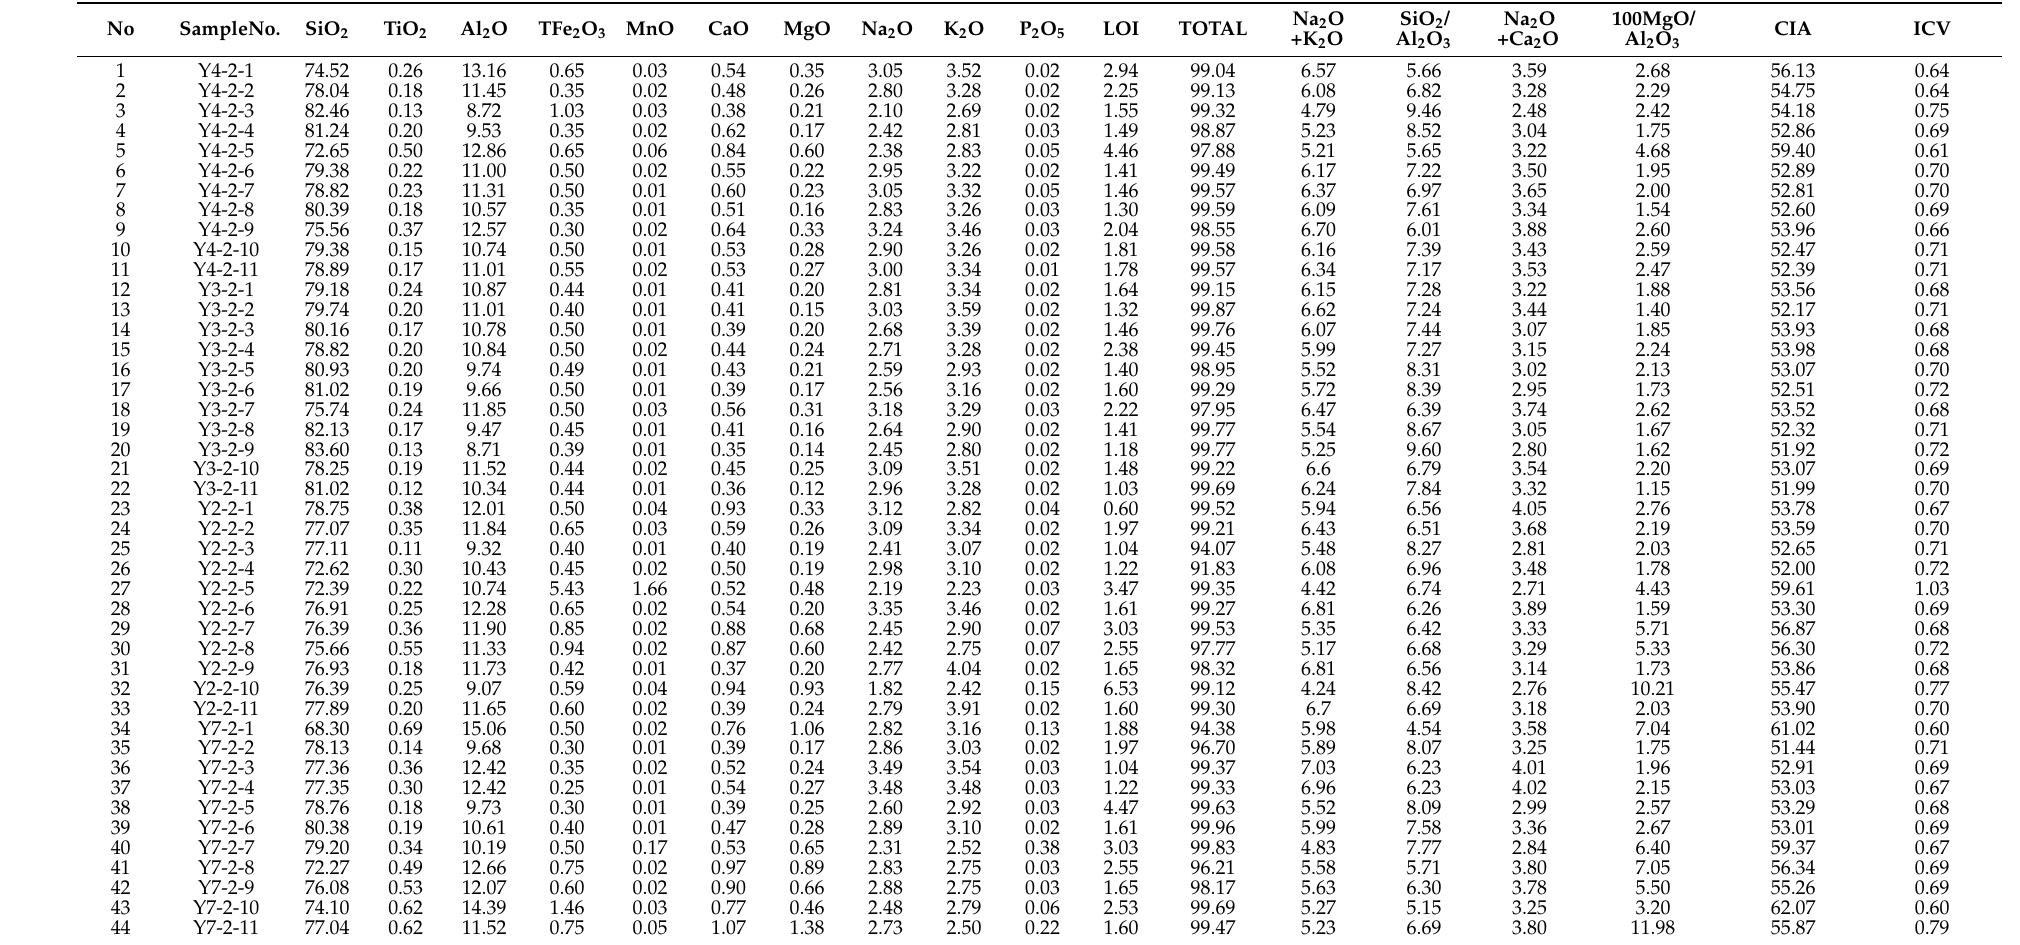
Table 1. Geochemical analysis of sandstone in the Sifangtai